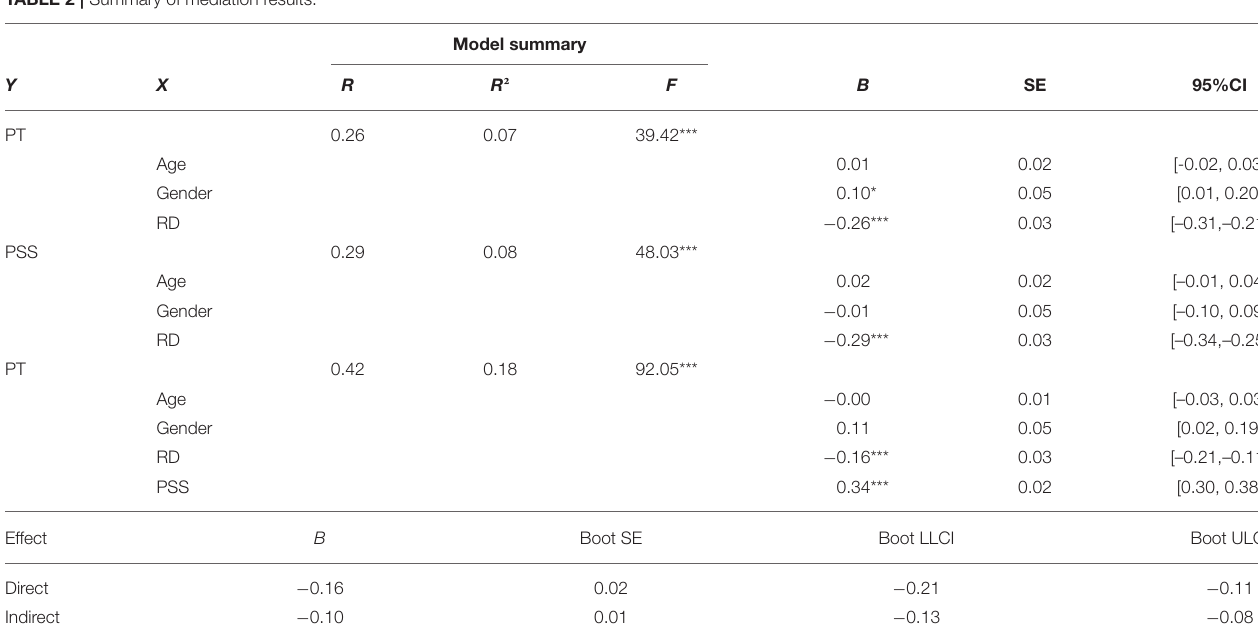
TABLE 2 | Summary of mediation